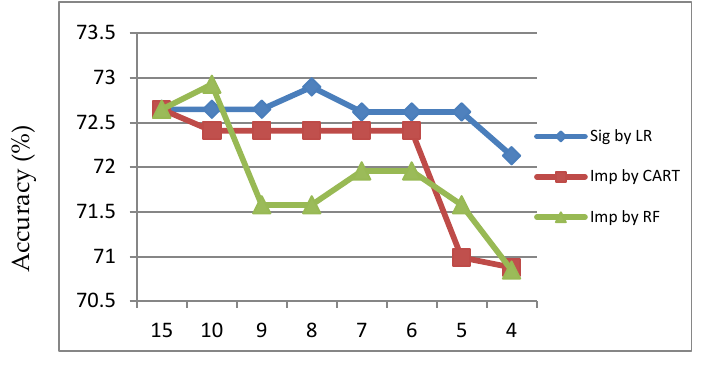
Figure 10. Accuracy of LR with input of significant or important variables.